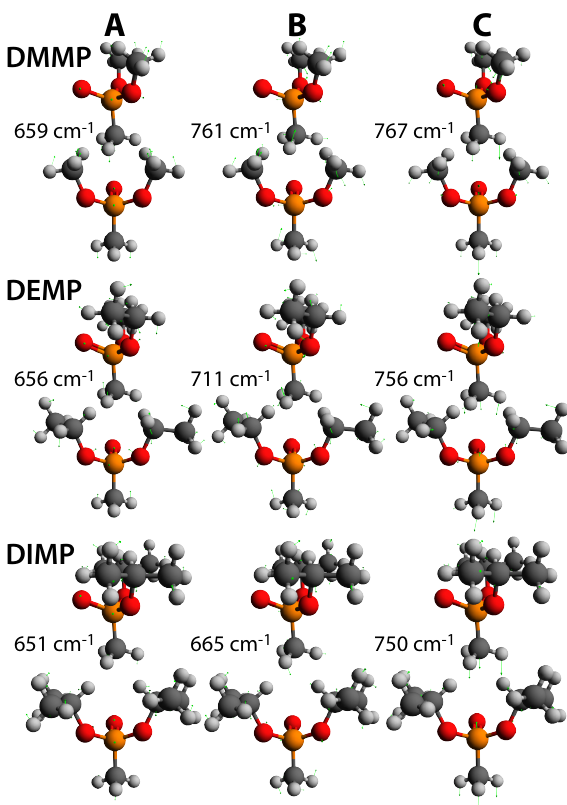
Figure 7. Potential coherently excited vibrational modes in DMMP, DEMP, and